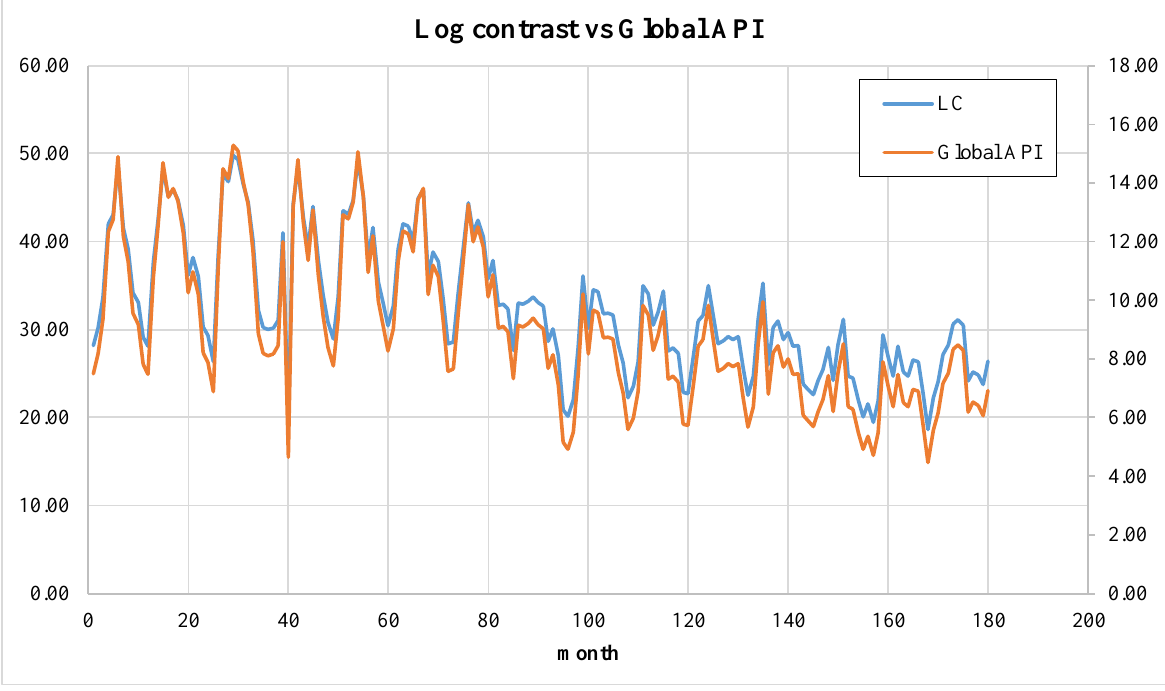
Figure 5. Log contrast (LC) and Air Pollution Index (API) evolution in Barcelona from 2001 to 2015.